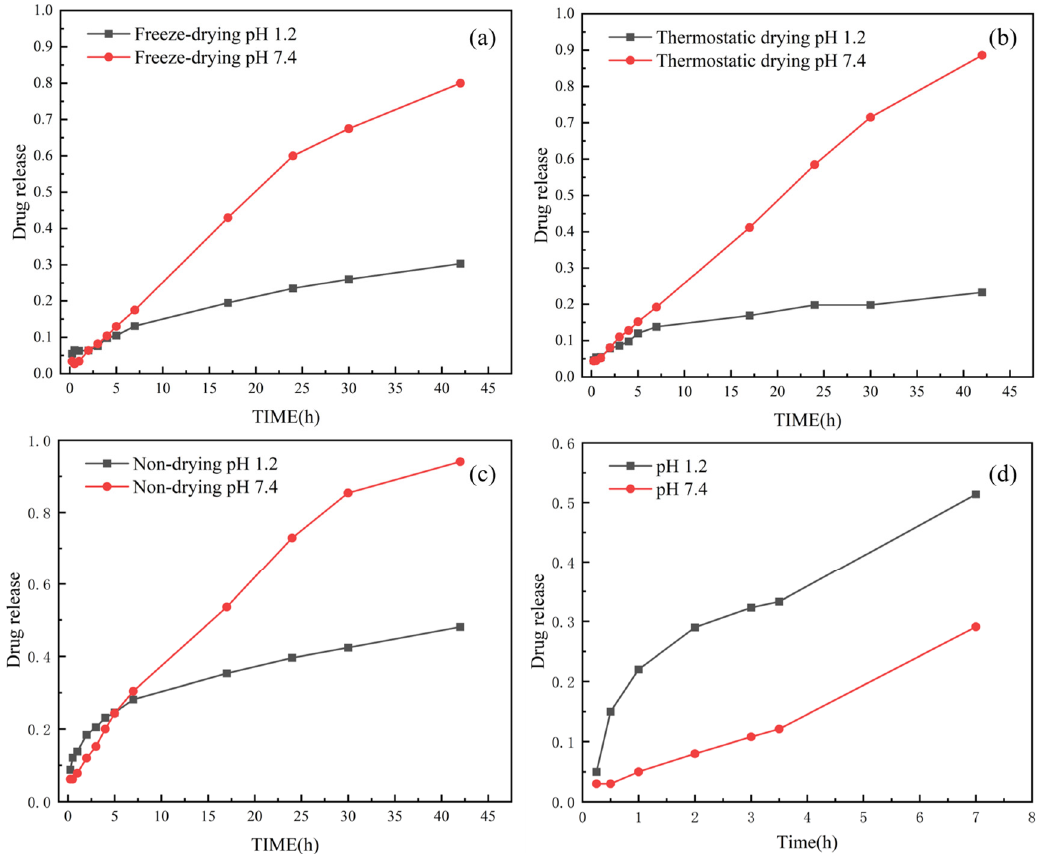
Figure 10. BSA release profiles under different conditions: ( a ) SA: CMCS = 3:1 and freeze-dried; ( b ) SA: CMCS = 3:1 and constant temperature-dried; ( c ) SA: CMCS = 3:1 and non-dried; and ( d ) SA: CMCS = 1:3.